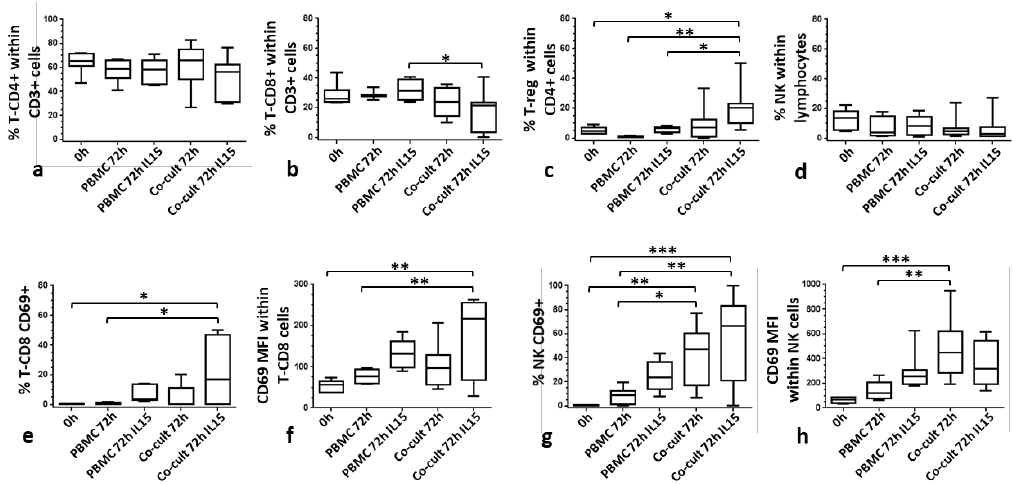
Figure 3. Comparison of the contents of lymphocyte subsets in CAISMOV24 cell aggregates obtained by 3D co-culture of CAISMOV24 cells with PBMCs. ( a ), ( b ) and ( c ) frequencies of T lymphocytes subsets T-CD4, T-CD8 and T-reg respectively, as well as ( d ) NK lymphocytes. ( b ) T-CD8+ subset is significant lower ( p < 0.05) in CAISMOV24 cell aggregates supplemented with IL-15 compared with PBMCs maintained in the same culture conditions. ( c ) T-reg subset is significantly higher ( p < 0.05) in CAISMOV24 cell aggregates supplemented with IL-15 compared to PBMCs cultures. CD69 molecule is upregulated on NK and CD8 lymphocytes retrieved from CAISMOV24 cell aggregates. ( e ) ( f ) CD69 upregulation on CD8+ lymphocytes is associated with supplementation of the culture with IL-15, while ( g ) ( h ) on NK lymphocytes it was associated with presence of CAISMOV24 cells. Values were presented as whisker plots and medians ( n = 7 experimental repetitions with different blood donors); statistical analyses were performed by ANOVA followed by Tukey’s multiple comparisons test. Significant statistical differences are indicated with * (* p < 0.05, ** p < 0.01 and *** p < 0.001).